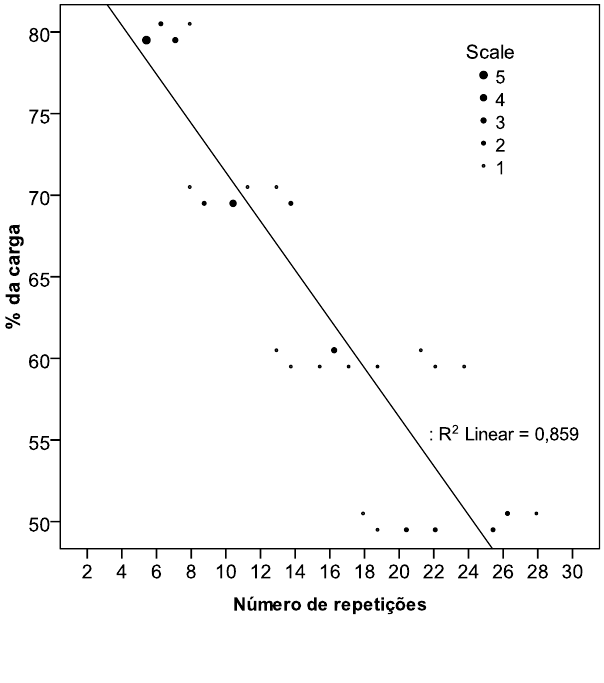
As figuras 4 e 5 abaixo, referentes aos exercícios supino e rosca scott respectivamente, mostram a dispersão dos valores nos diferentes percentuais avaliados (50, 60, 70, e 80%), sendo possível perceber que esta dispersão reduz-se à medida que o percentual aumenta em ambos os exercícios. Figura 4- Dispersão dos valores no supino nos diferentes percentuais de 1RM